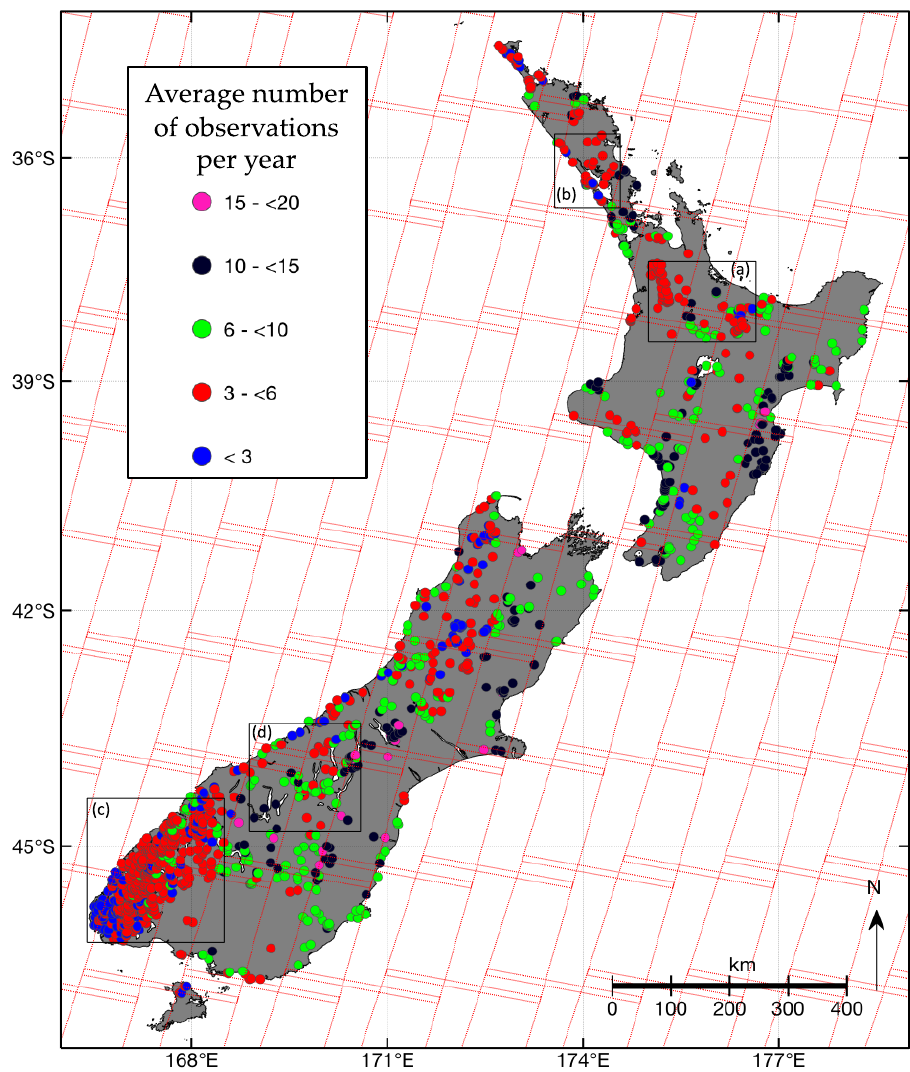
Figure 5. 1486 lakes coloured by the average number of observations per year. The red rectangles delineate the geographic locations of the Landsat 8 OLI path/row scene boundaries of the descending (daytime) node in WRS-2 [49]. The boxes ( a – d ) show the locations of the closeup maps of Figure 6 and Figure 9.